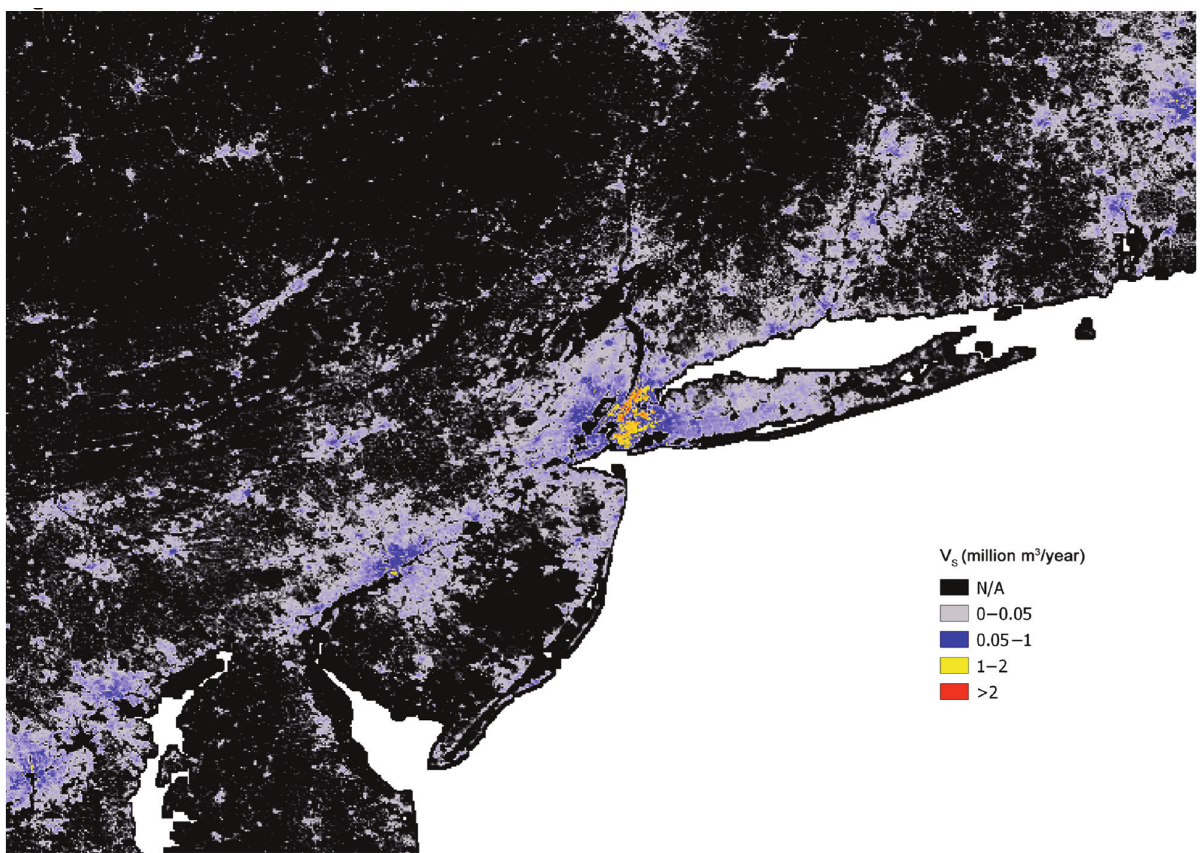
Service water withdrawal for the ) spatialised using year 2018 ( V s 2018 the GHSL population density layer and the JMP database (access to water through ‘basic services’). This figure shows the New York area in the United States. Geographic projection. Spatial resolution 30 arc-seconds (approximately 1 km at the